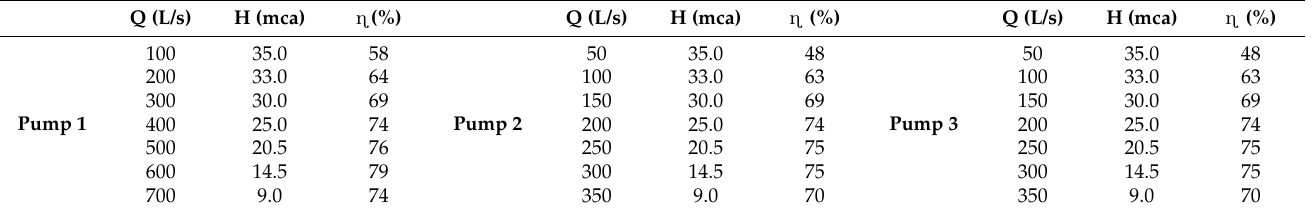
Table 1. Characteristics of the pipes coupled to the 3 representative pumps adopted to pump from the river to the desander of the river channel—Rio Branco/Acre [36].